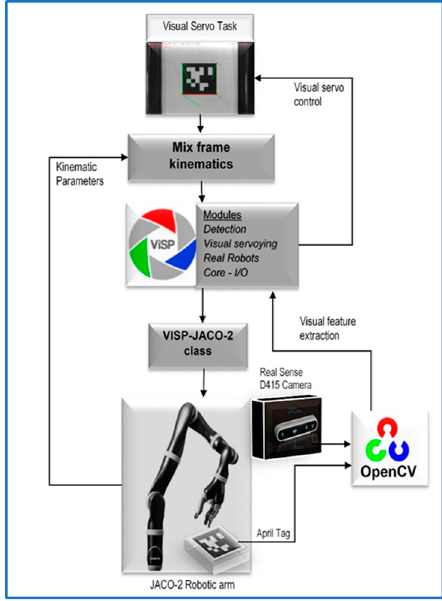
Figure 8. Mixed frame visual servo control experiment.